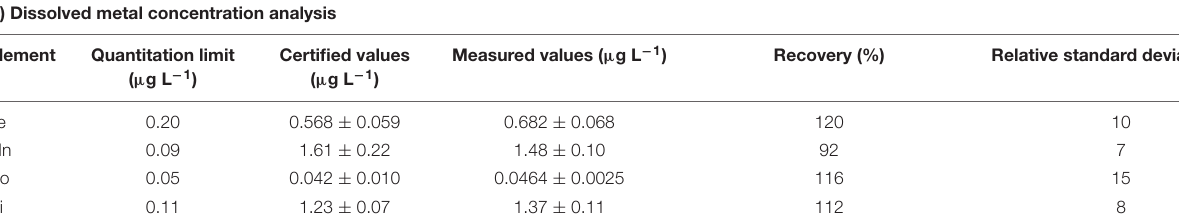
TABLE 1 | Quality control of analytical methods applied for dissolved and particulate metal concentration analysis including accuracy, precision, and quantitation limit, using: (a) estuarine water SLEW-3; (b) sediment BCR-277R. (a) Dissolved metal concentration